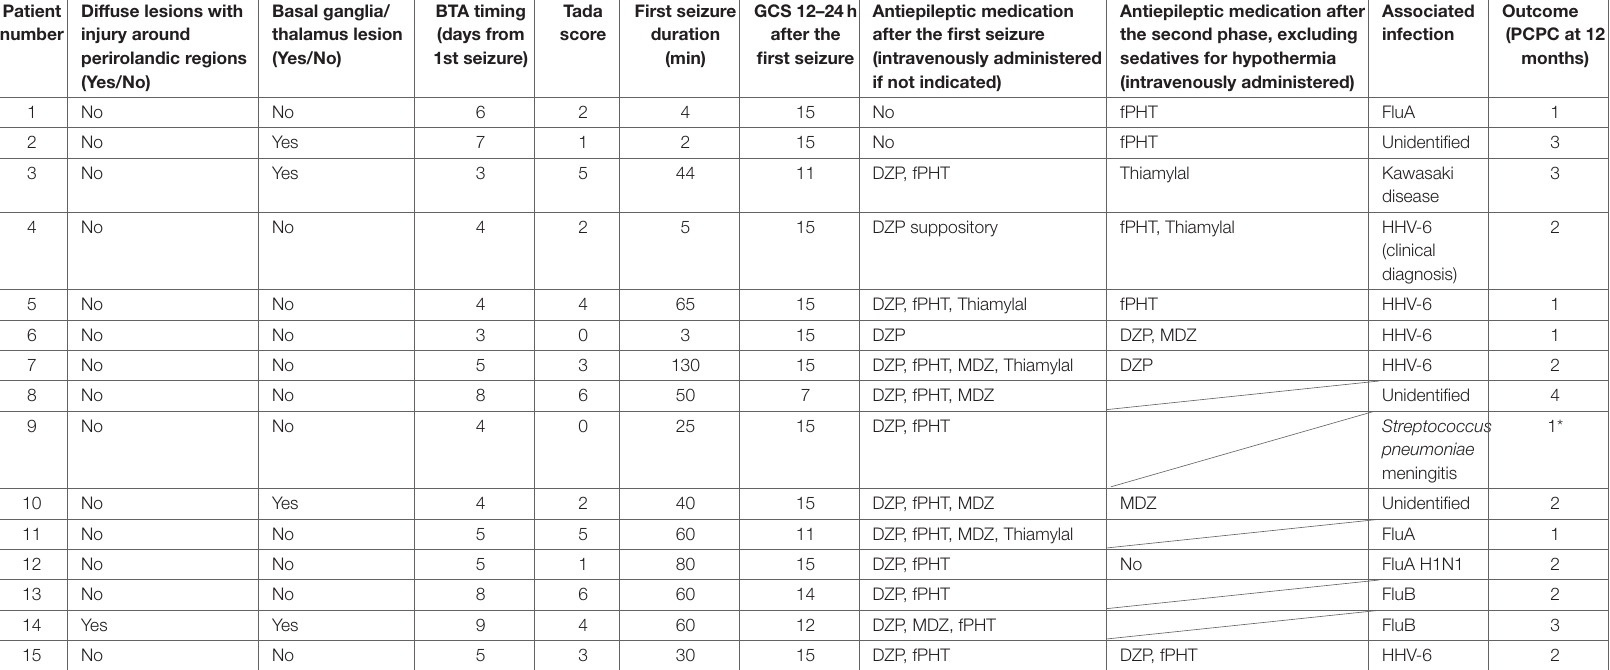
TABLE 2 | Additional clinical characteristics of the sample. Patient Diffuse lesions with number injury